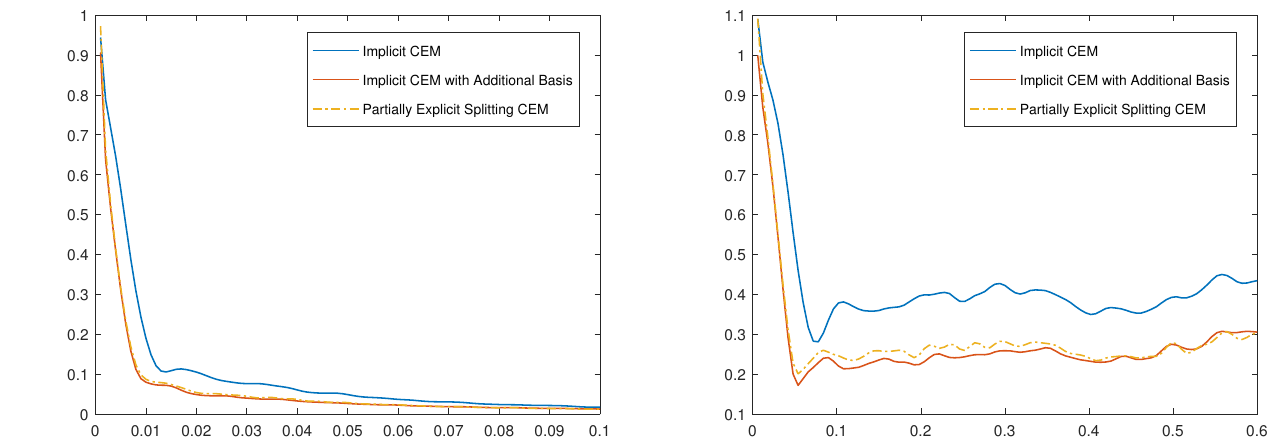
Figure 3. α = 0.5, dt = 0.006. Left : L 2 error. Right : Energy error.